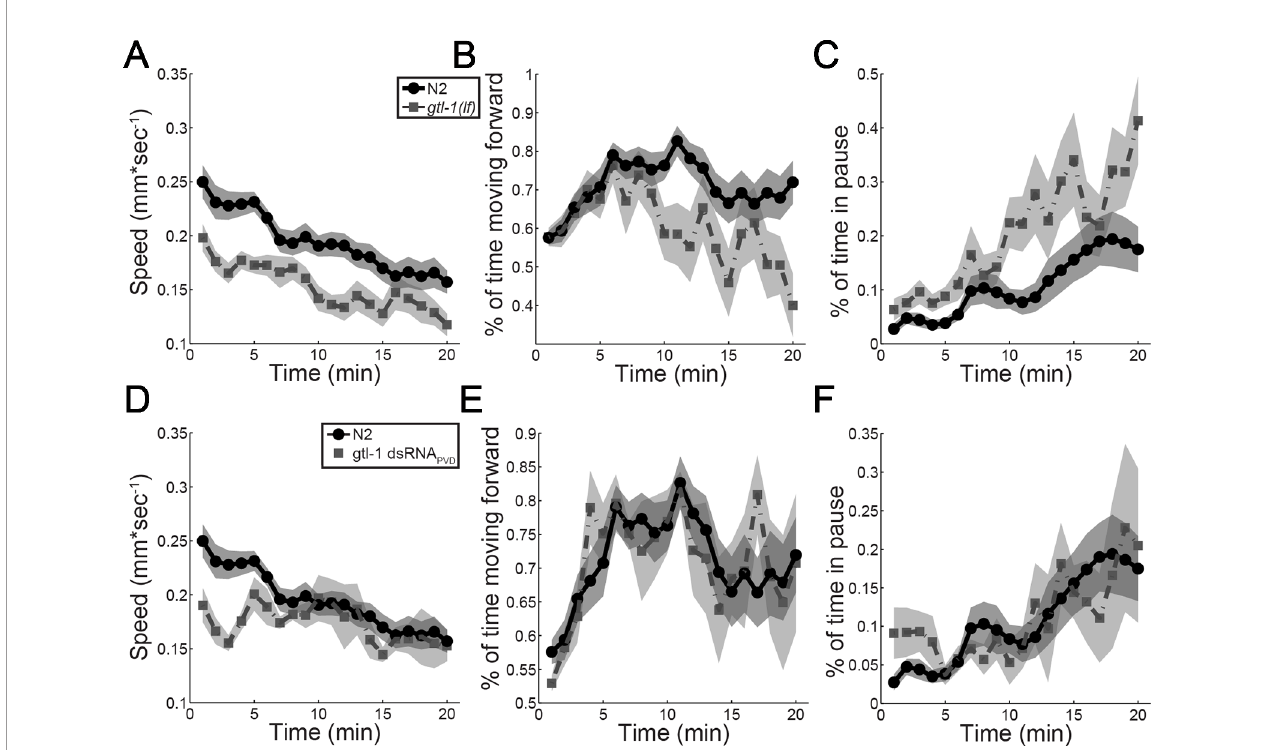
FIGURE 4 | GTL-1 affects the magnitude of the response to noxious mechanical stimuli. Immediate and enduring responses to a noxious mechanical stimulus of wild-type (N2, N = 19, circles) compared to gtl-1(lf) (n = 13, squares) (A – C) and wild-type (N2, n = 19, circles) compared to gtl-1 dsRNA PVD (n = 5, squares) (D – F)